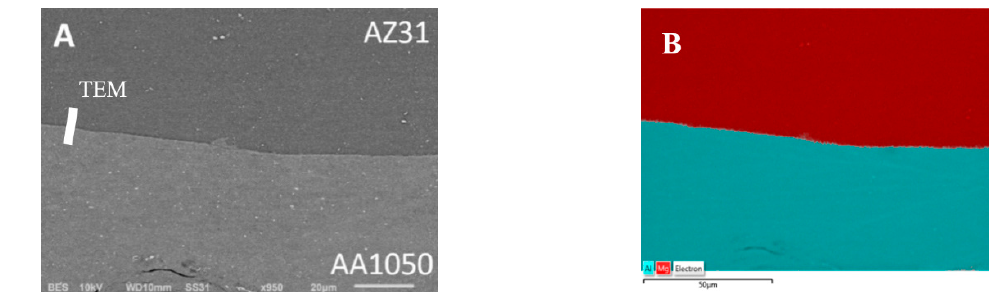
Figure 11. AZ31 / AA1050 joint in as-welded state: ( A ) SEM results, ( B ) Mg and Al elements distribution on the sample surface.